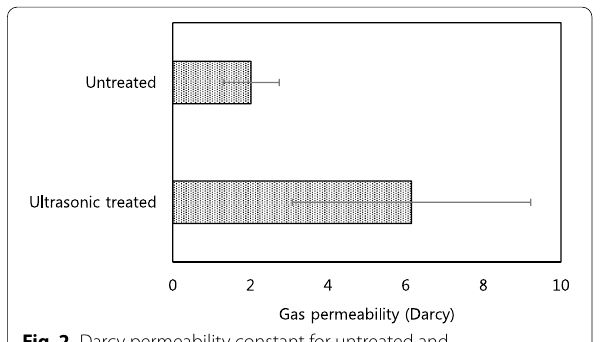
Fig. 2 Darcy permeability constant for untreated and ultrasonic‑treated Malas ( error bar is SD) Fig. 3 Average sound absorption coefficients of the untreated and